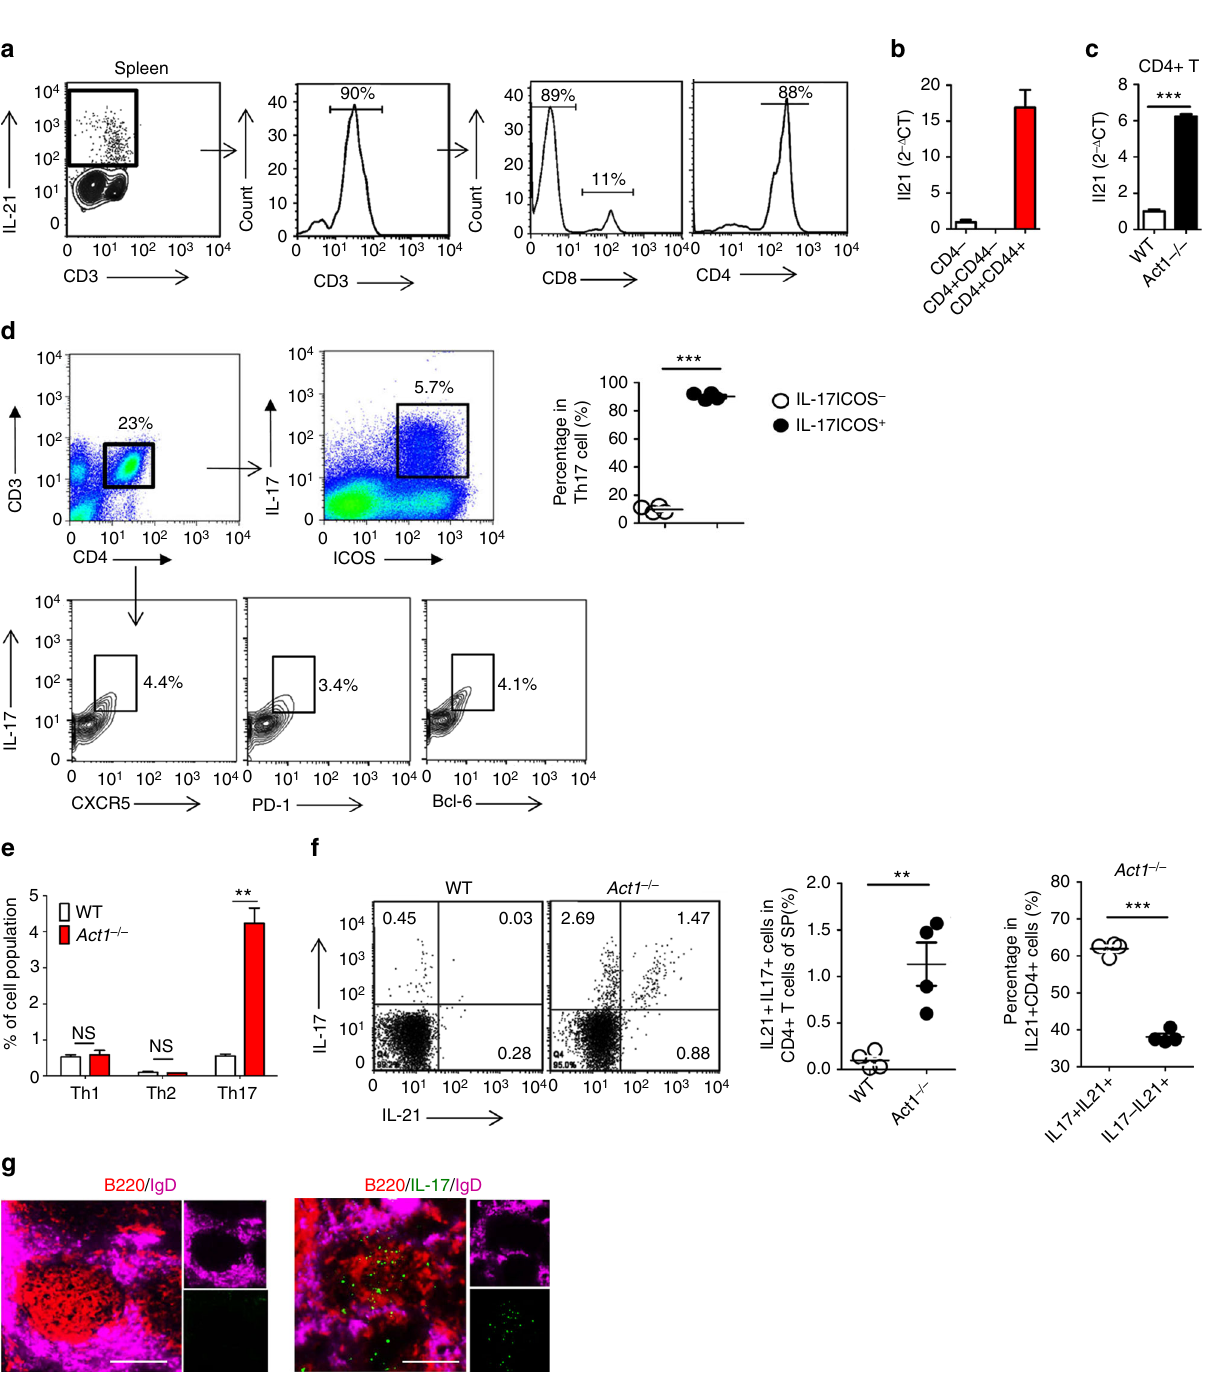
Fig. 4 Th17 cells are the major sources of IL-21 in Act1 − / − mice. a Flow cytometry analysis of IL-21 + CD3 + , IL-21 + CD4 + , and IL-21 + CD8 + T cells in spleen from 8 months old Act1 − / − mice. b , c RT-PCR analysis of IL-21 transcript in the sorted CD4 − , CD4 + CD44 − and CD4 + CD44 + T cells from spleen of 8 months old Act1 − / − mice ( b ) and CD4 + T cells from spleen of WT or Act − / − mice ( c ). d Flow cytometry analysis of ICOS + IL17 + Th17 cells and other Tfh markers (CXCR5, PD-1, and Bcl-6) in spleen of 8 months old Act − / − mice. e Flow cytometry analysis of Th1 (CD3 + CD4 + IFN γ + ), Th2 (CD3 + CD4 + IL-4 + ), and Th17 (CD3 + CD4 + IL17A + ) cells in spleen of 8 months old Act1 − / − mice and WT control mice. f Flow cytometry analysis of CD3 + CD4 + IL-17 + IL-21 + cell in spleen of 8 months old mice. g Spleens collected from Act1 − / − mice were stained with antibodies against B220, IL-17, and lgD. Scale bars: 100 μ m. N = 4 – 7/group. Mean± SEM. ** p < 0.01, *** p < 0.001. Two-tailed Student ’ s T test. All the data presented were from two independent